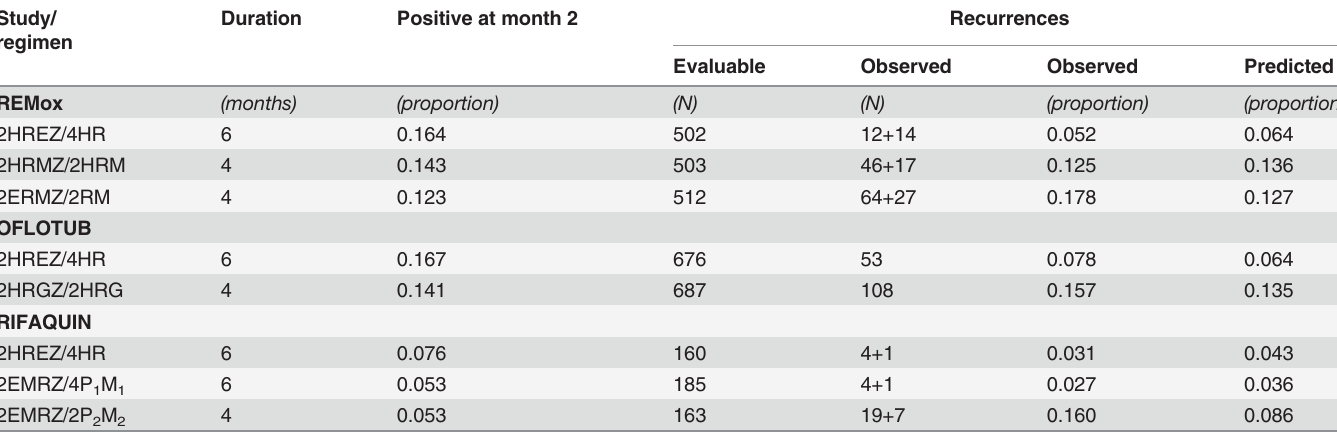
Table 2. Observed and predicted relapse rates in arms of three phase 3 trials of fluoroquinolone-containing